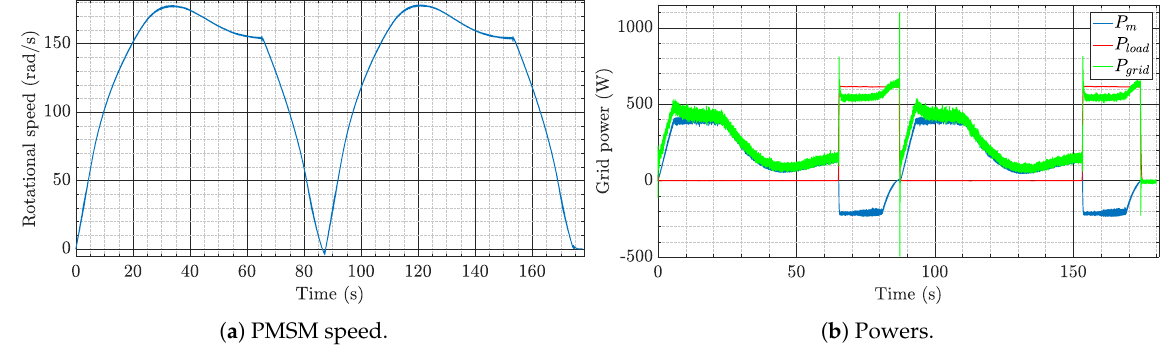
Figure 17. Experimental results for power peak